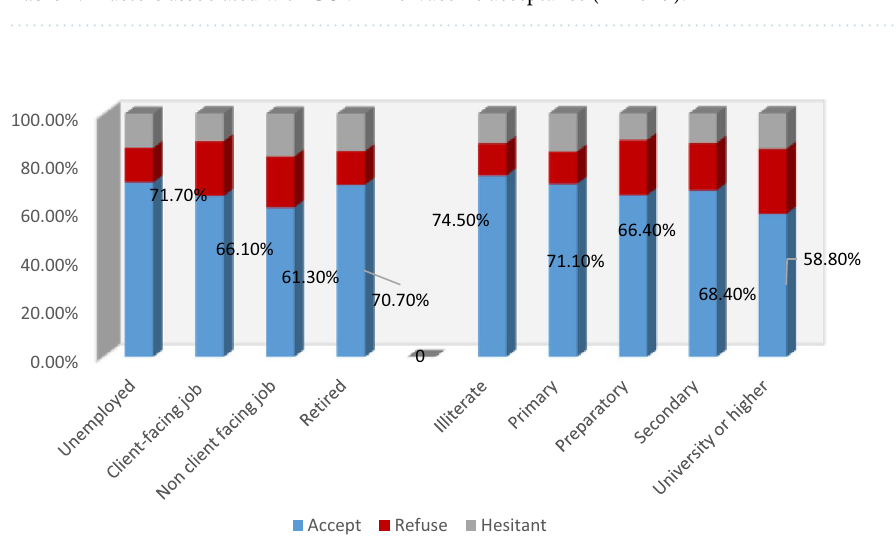
Table 1. Factors associated with COVID-19 vaccine acceptance (n = 2919).